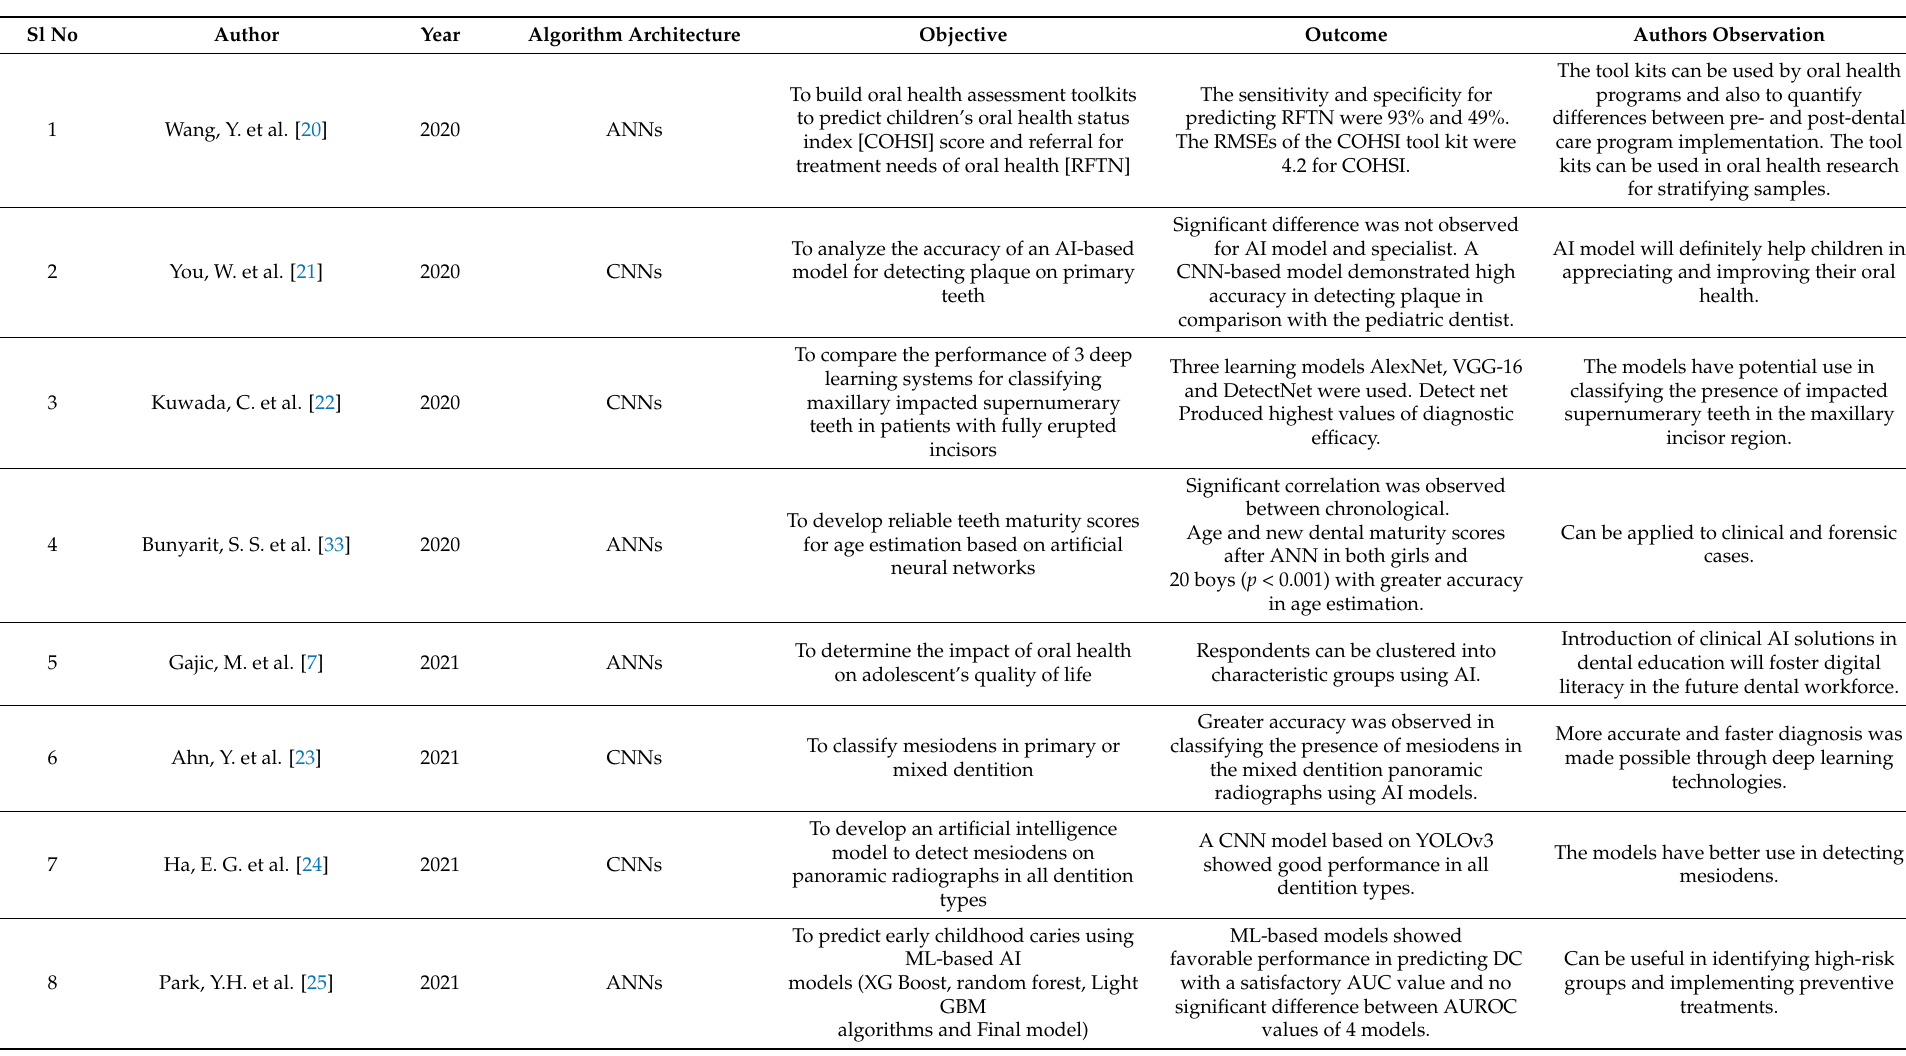
Table 1. Details of the studies that reported AI-based models in pediatric